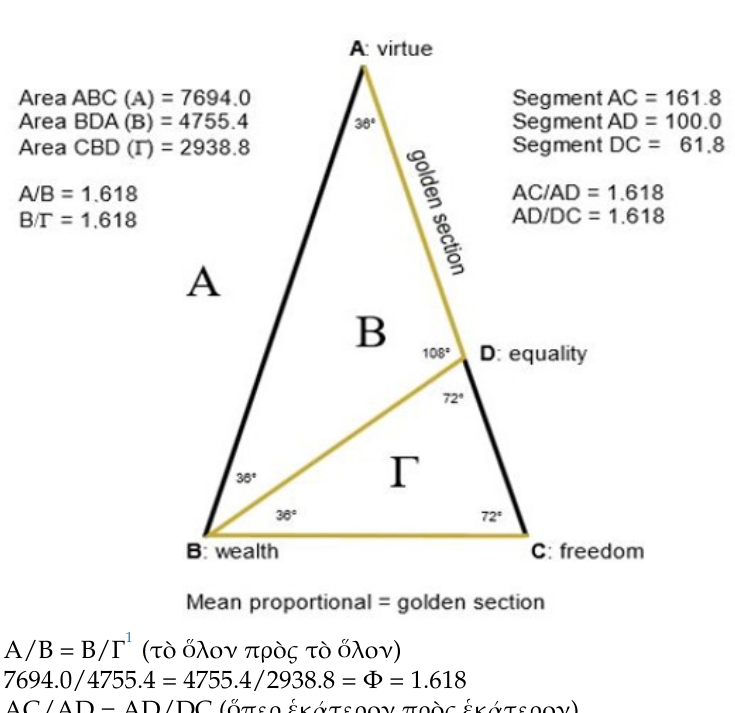
Figure 1. The Mean Term of Aristotle’s Distributive Justice is the Golden Ratio between the Three opposing Criteria of Distribution: Freedom, Wealth and Virtue.